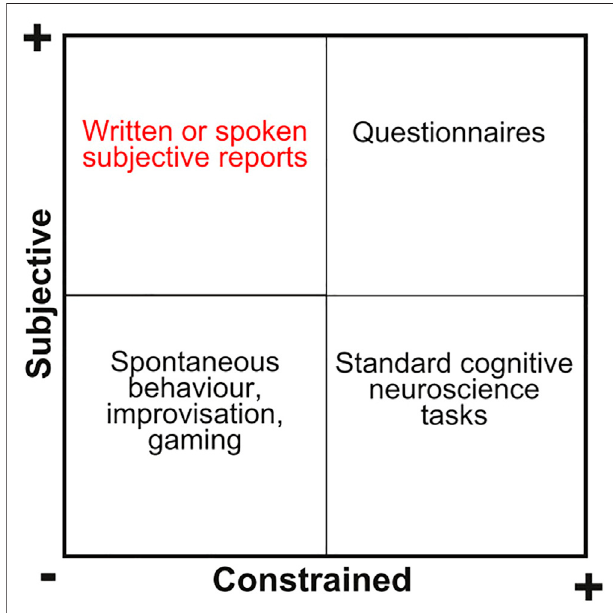
FIGURE 1 | Different ways of approaching the study of the effects of psychedelic drugs. The fi rst dimension ( x axis) indexes whether the experimental paradigm constrains subjects to adopt a set of prede fi ned behavioral patterns (for instance, when interacting with the interface of a rigidly scripted cognitive experiment). The second dimension ( y axis) indexes whether the experiment intends to gather information related to the subjective experience of the participants, or to measure their capacity to perform certain tasks or to achieve speci fi c goals. Natural language reports, the main topic of this review, constitute a comparatively unconstrained method to investigate the effects of psychedelic drugs on subjective experience and spontaneous cognitive